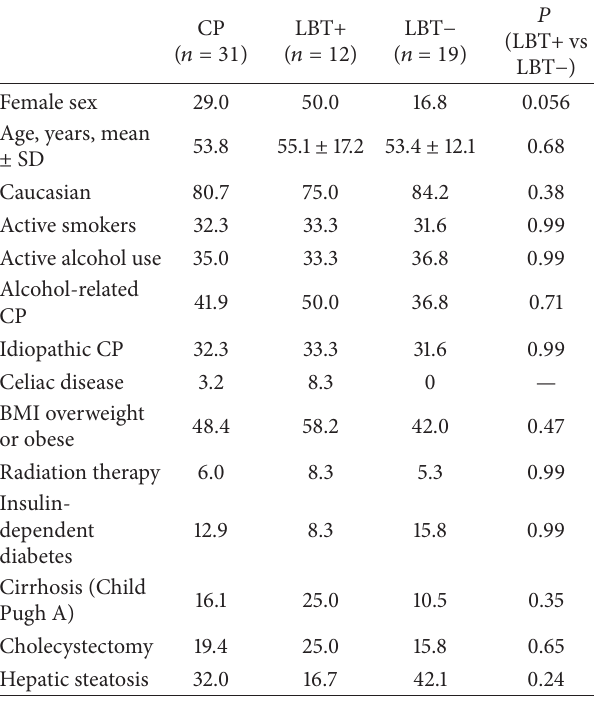
Table 1: Characteristics of patients with chronic pancreatitis (CP) and comparison between groups with positive (+) and negative ( − ) lactulose breath test (LBT).